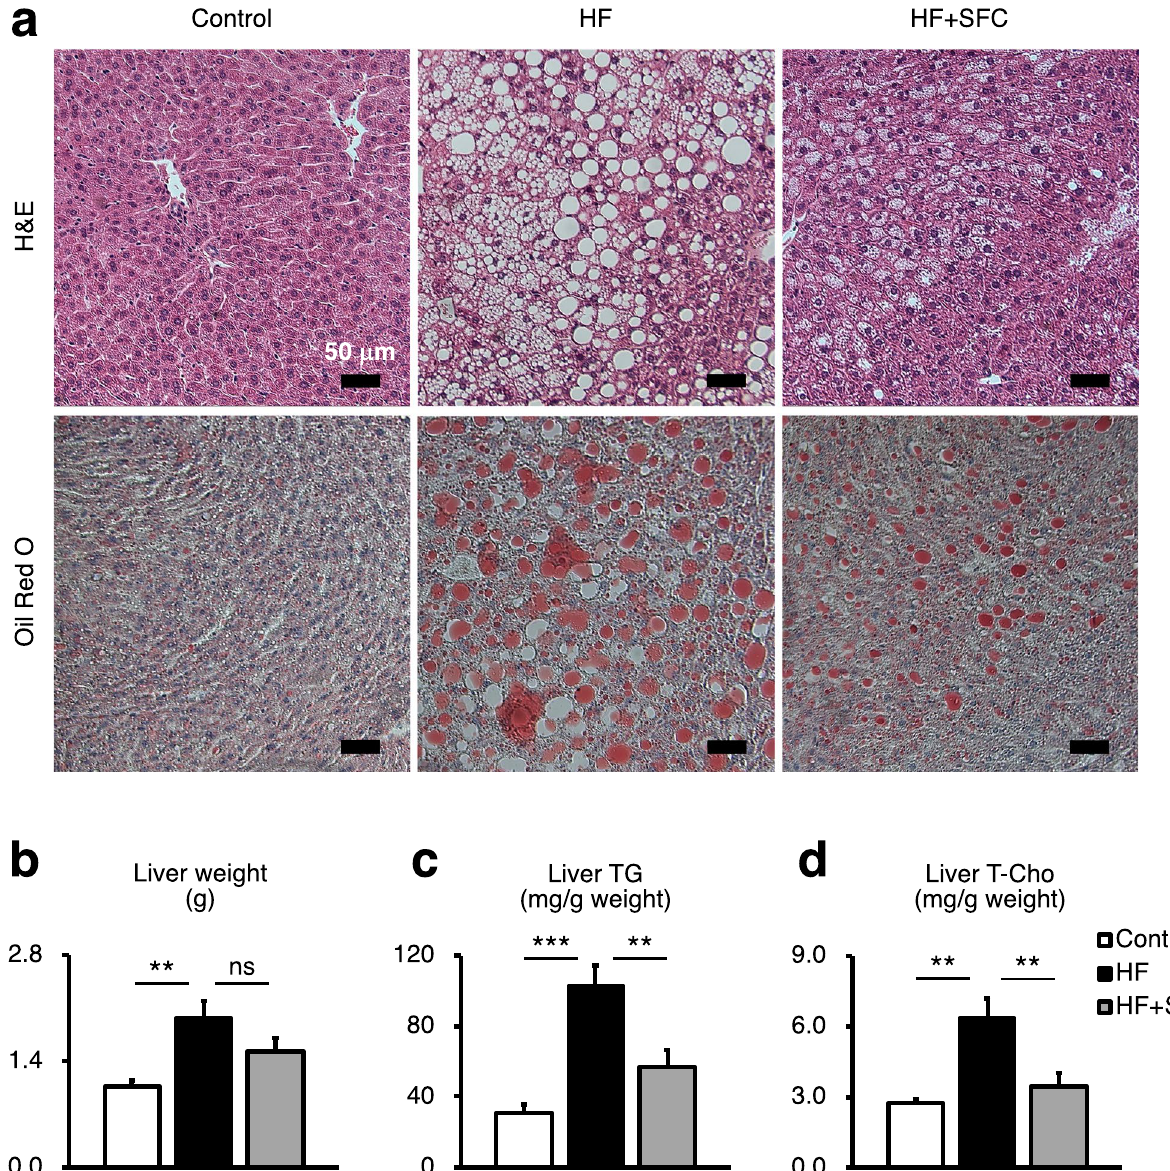
Figure 3. Iron supplementation reduces hepatic lipid accumulation. ( a – d ) Male C57BL/6J mice of 6 weeks of age were fed with each diet for 15 weeks as specified in Fig. 1. ( a ) Representative image of Hematoxylin–eosin (H&E) and Oil Red O stained liver sections. Scale bar is 50 μm. ( b ) Weight of liver ( n = 5–6). ( c , d ) ( c ) Liver triglycerides (TG); and ( d ) total cholesterol (T-Cho) content ( n = 5–6). The values were corrected by the tissue weight. Data are expressed as mean ± SEM values. Statistical analysis was performed using one-way ANOVA followed by Holm–Sidak’s post hoc test. ** p < 0.01; *** p < 0.001; ns, not significant. (Significant differences vs.